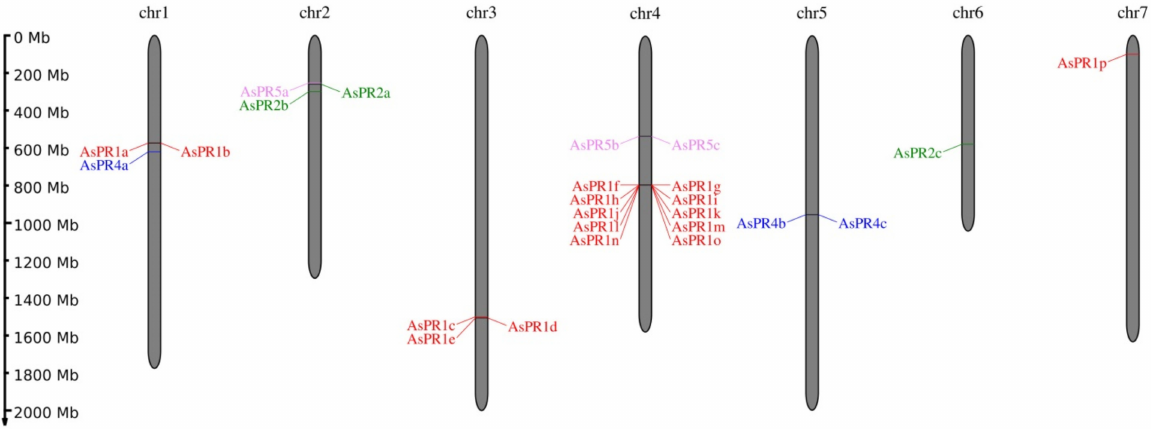
Figure 1. Chromosomal locations of the AsPR1 (red), AsPR2 (green), AsPR4 (blue), and AsPR5 (purple) genes. The chromo- some lengths indicated on the left are based on the A. sativum cv. Ershuizao genome (PRJNA606385) [31]; chr,